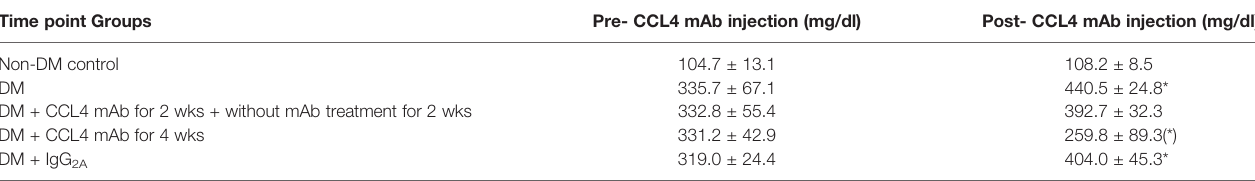
TABLE 1 | Blood sugar levels in STZ-induced diabetic mice. Time point